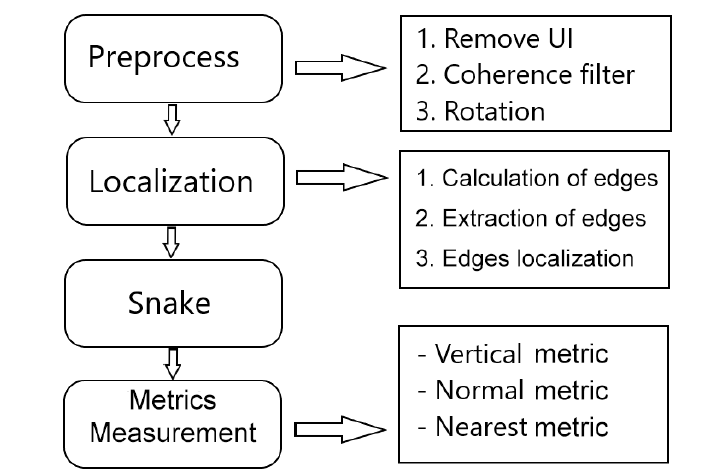
Figure 2. General scheme of the proposed